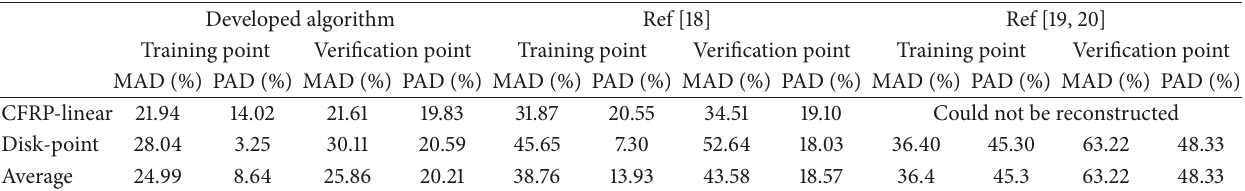
Table 4: Reconstruction results and comparison of the proposed algorithm and previous